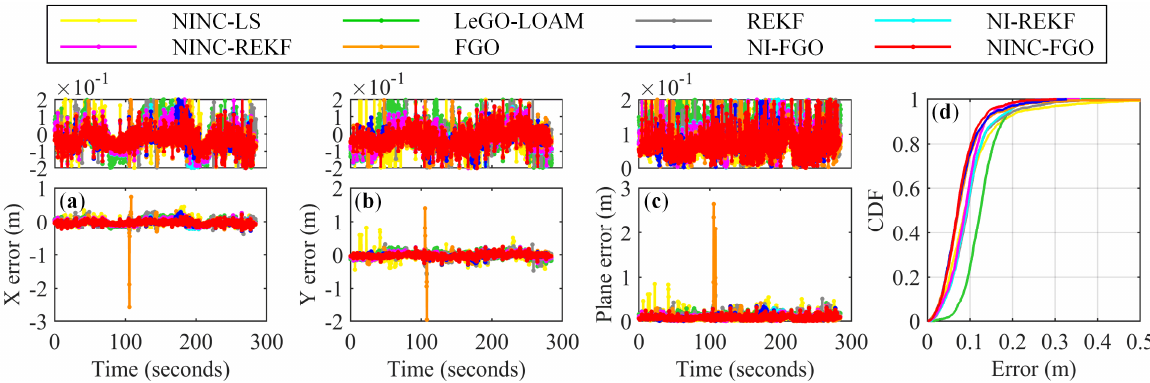
Figure 13. Trajectories of the eight methods: NINC-LS (yellow), LeGO-LOAM (green), REKF (grey), NI-REKF (cyan), NINC-REKF (magenta), FGO (orange), NI-FGO (blue) and NINC-FGO (red).